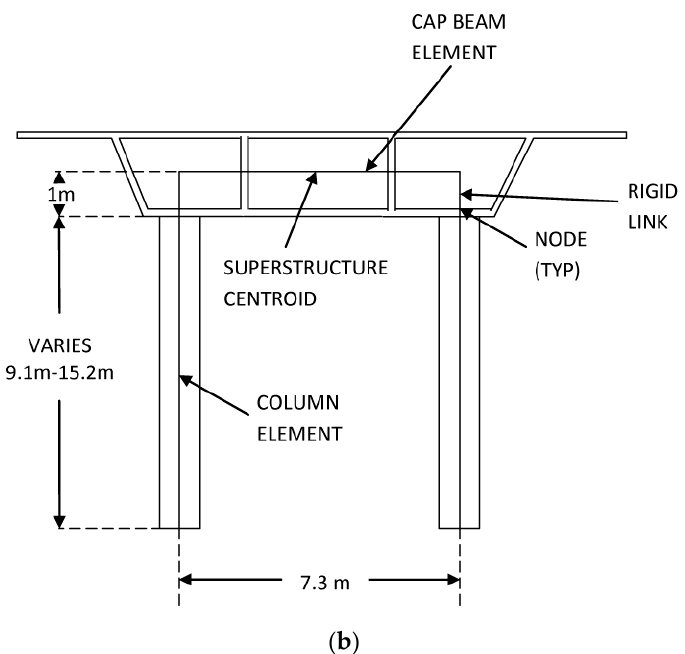
Figure 3. Bridge model: ( a ) entire bridge structure and ( b ) pier frame (reproduced from Zhu et al. [27]).